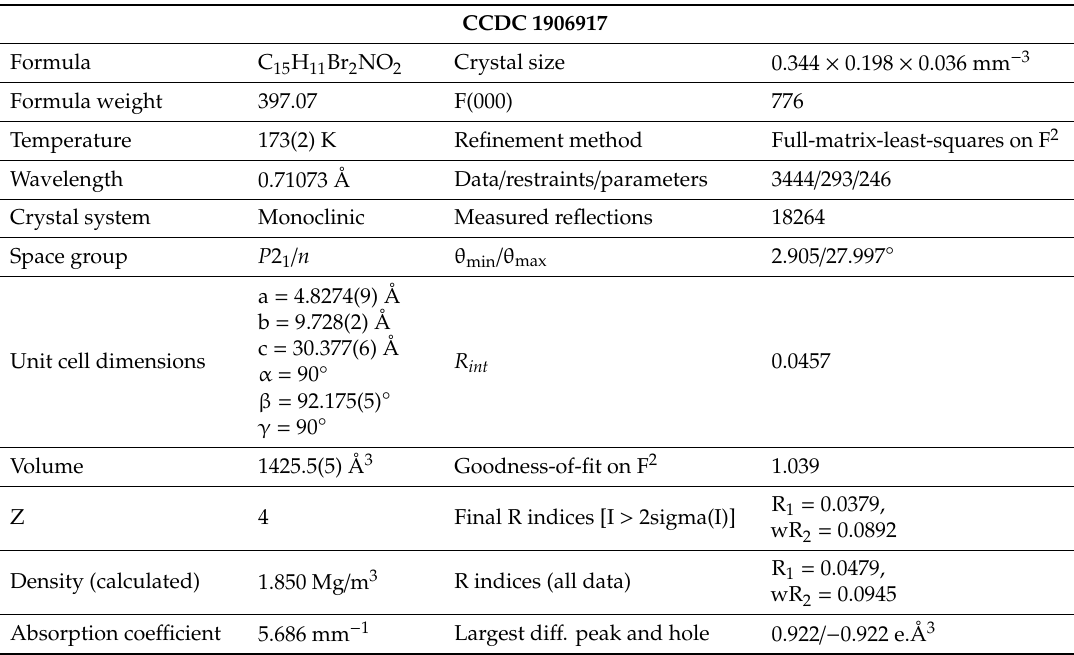
Table 1. Crystal data and structure refinement for compound 2a .